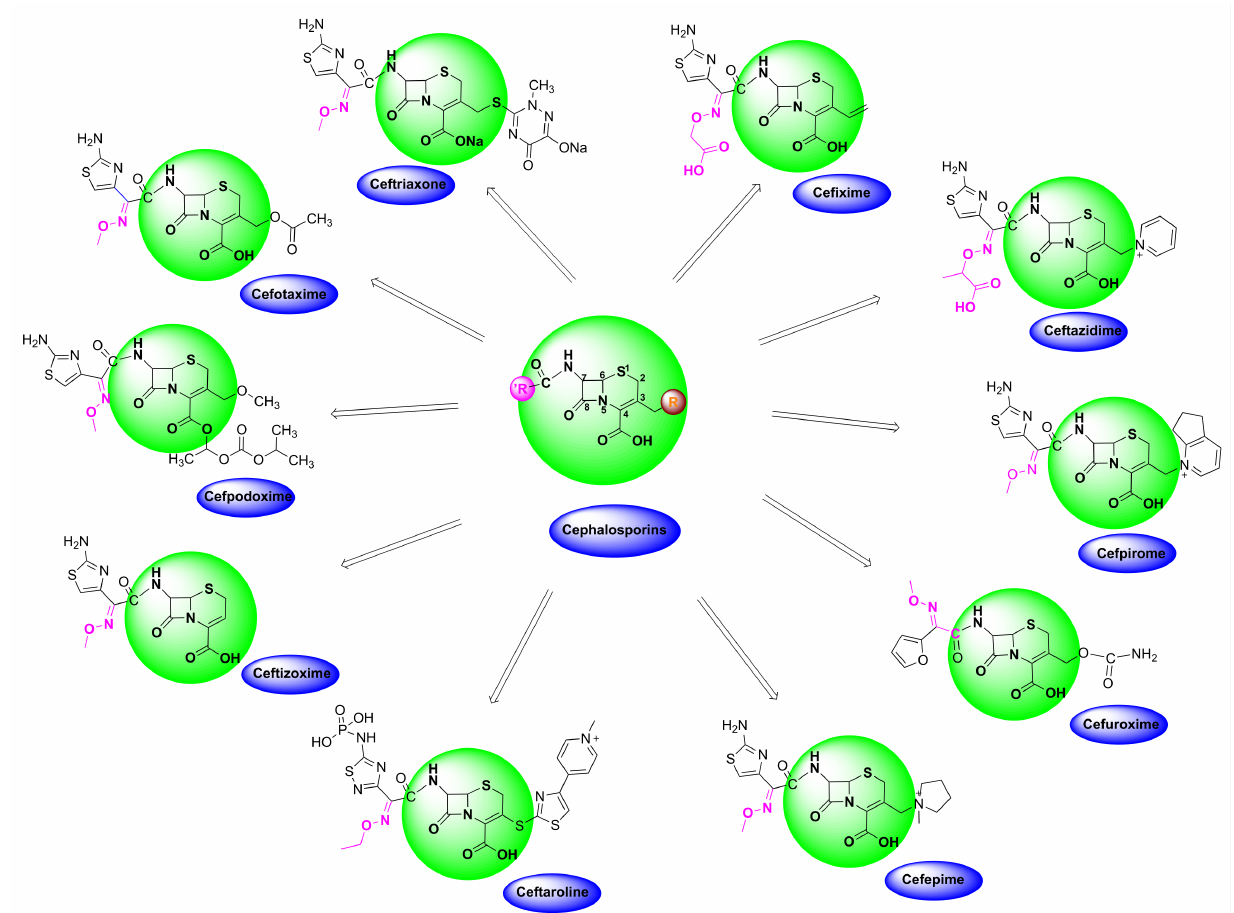
Figure 11. Representative examples of cephalosporin-based